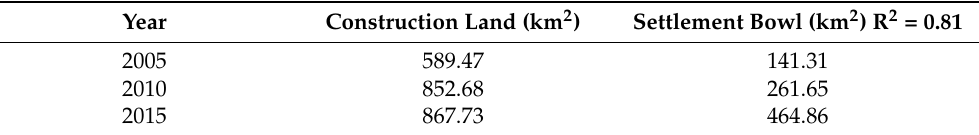
Table 3. Relationship between construction land and settlement bowl (>50 mm/year).